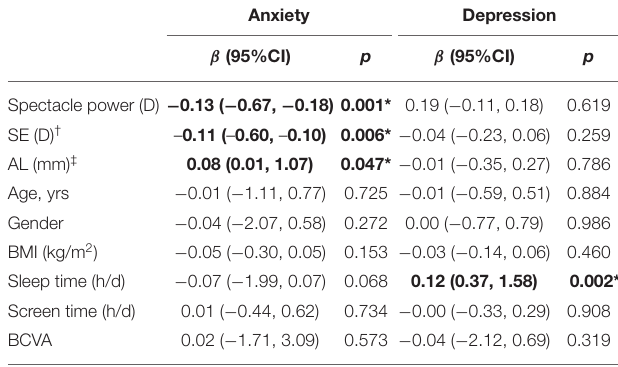
Corrected Visual Acuity. Model1adjustedforage,gender,BMI,sleeptime,screentime,BCVA,andglassdiopters. † Model 2 adjusted for age, gender, BMI, sleep time, screen time, BCVA, and SE. ‡ Model 3 adjusted for age, gender, BMI, sleep time, screen time, BCVA, and